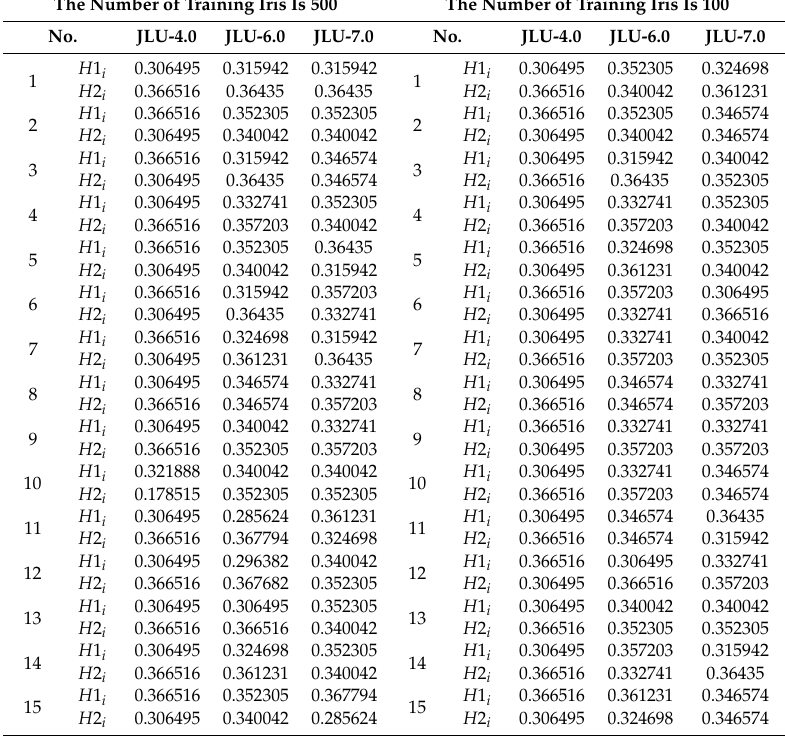
Table 8. The information entropy H 1 i and H 2 i of 15 recognition parameters of 500 training